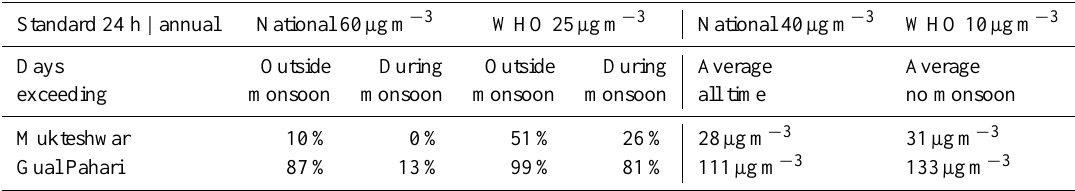
Table 4. Percentage of days exceeding the 24h PM 2 . 5 guideline value set either by the Indian National Air Pollution Board or the WHO. In addition the campaign averages are shown in ambient concentrations with and without the monsoon season.